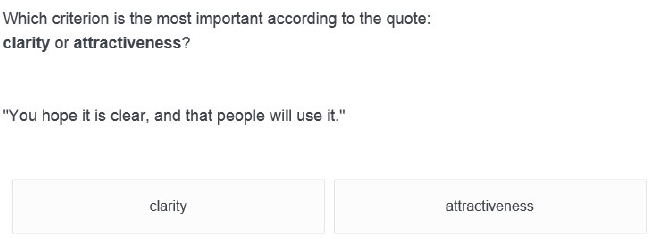
Figure 1. Example of statement and scale from the interpretation survey.